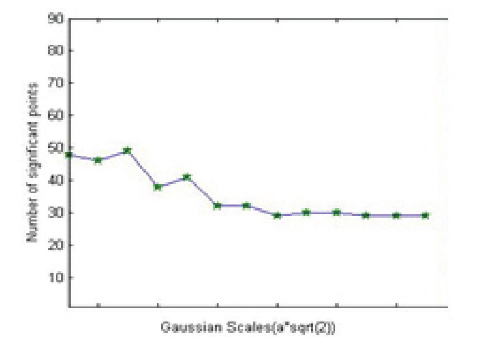
Figure 11 (a) Feature Point Image(52 points/) (b) Gaussian blur (cid:11)(cid:305)(cid:32)(cid:20)(cid:12)(cid:11)(cid:23)(cid:27)(cid:3)(cid:83)(cid:82)(cid:76)(cid:81)(cid:87)(cid:86)(cid:12)(cid:3)(cid:11)(cid:70)(cid:12) Gaussian blur (cid:11)(cid:305)(cid:3)(cid:32)(cid:20)(cid:17)(cid:26)(cid:19)(cid:26)(cid:12)(cid:11)(cid:23)(cid:25)(cid:3)(cid:83)(cid:82)(cid:76)(cid:81)(cid:87)(cid:86)(cid:12) (cid:11)(cid:71)(cid:12)(cid:3)(cid:42)(cid:68)(cid:88)(cid:86)(cid:86)(cid:76)(cid:68)(cid:81)(cid:3)(cid:69)(cid:79)(cid:88)(cid:85)(cid:3)(cid:11)(cid:305)(cid:3)(cid:32)(cid:21)(cid:12)(cid:11)(cid:23)(cid:28)(cid:3)(cid:83)(cid:82)(cid:76)(cid:81)(cid:87)(cid:86)(cid:12)